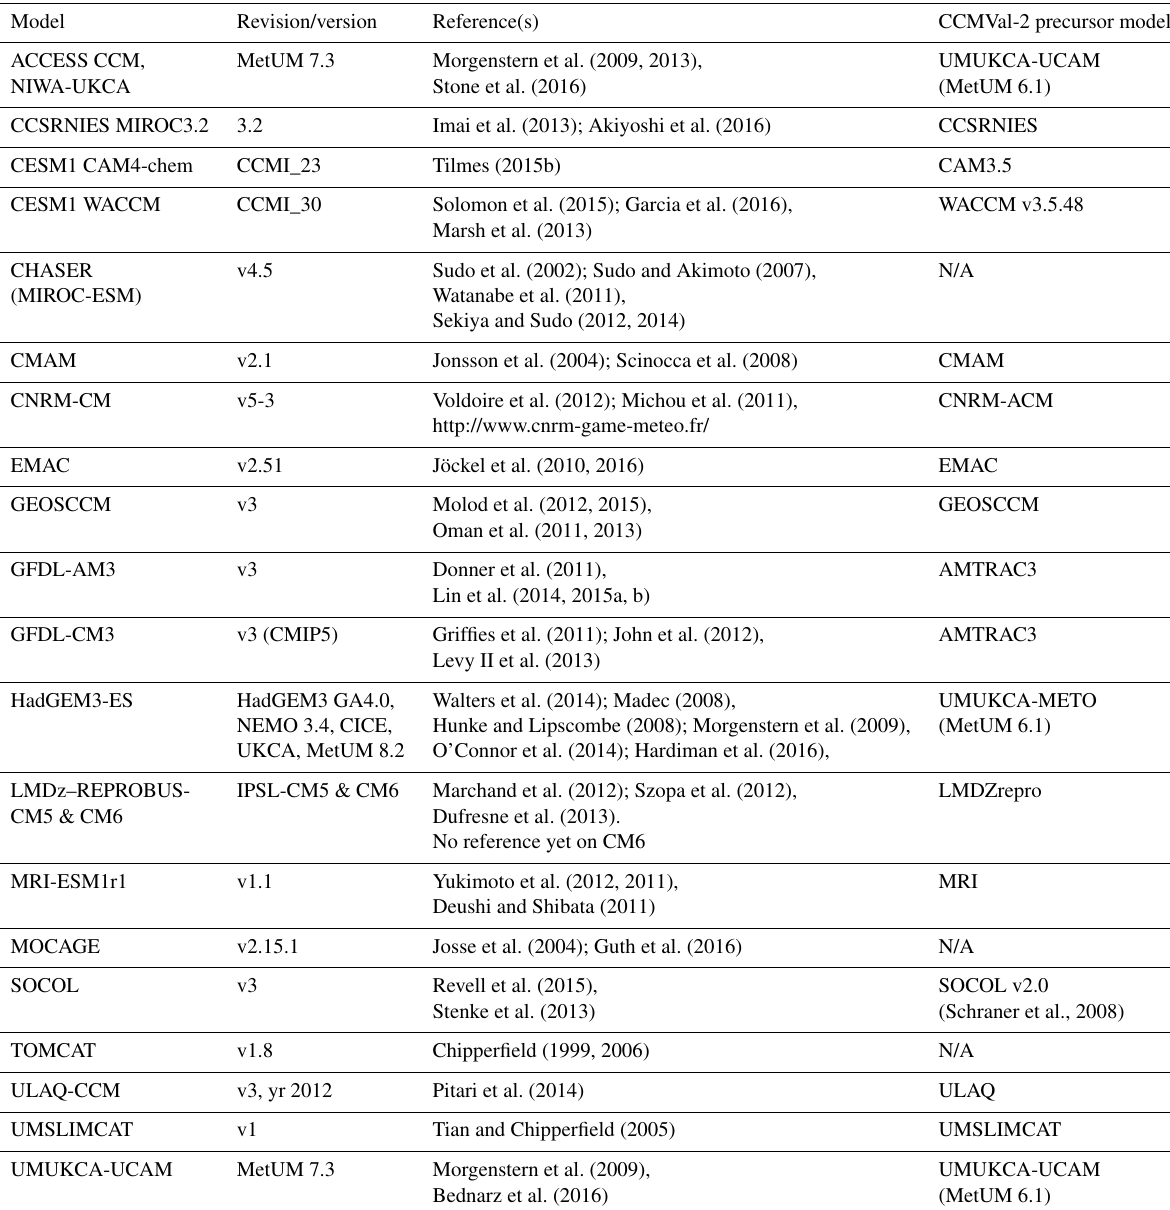
Table 2. Model versions and key references. More details on the CCMVal-2 versions are in Morgenstern et al. (2010).